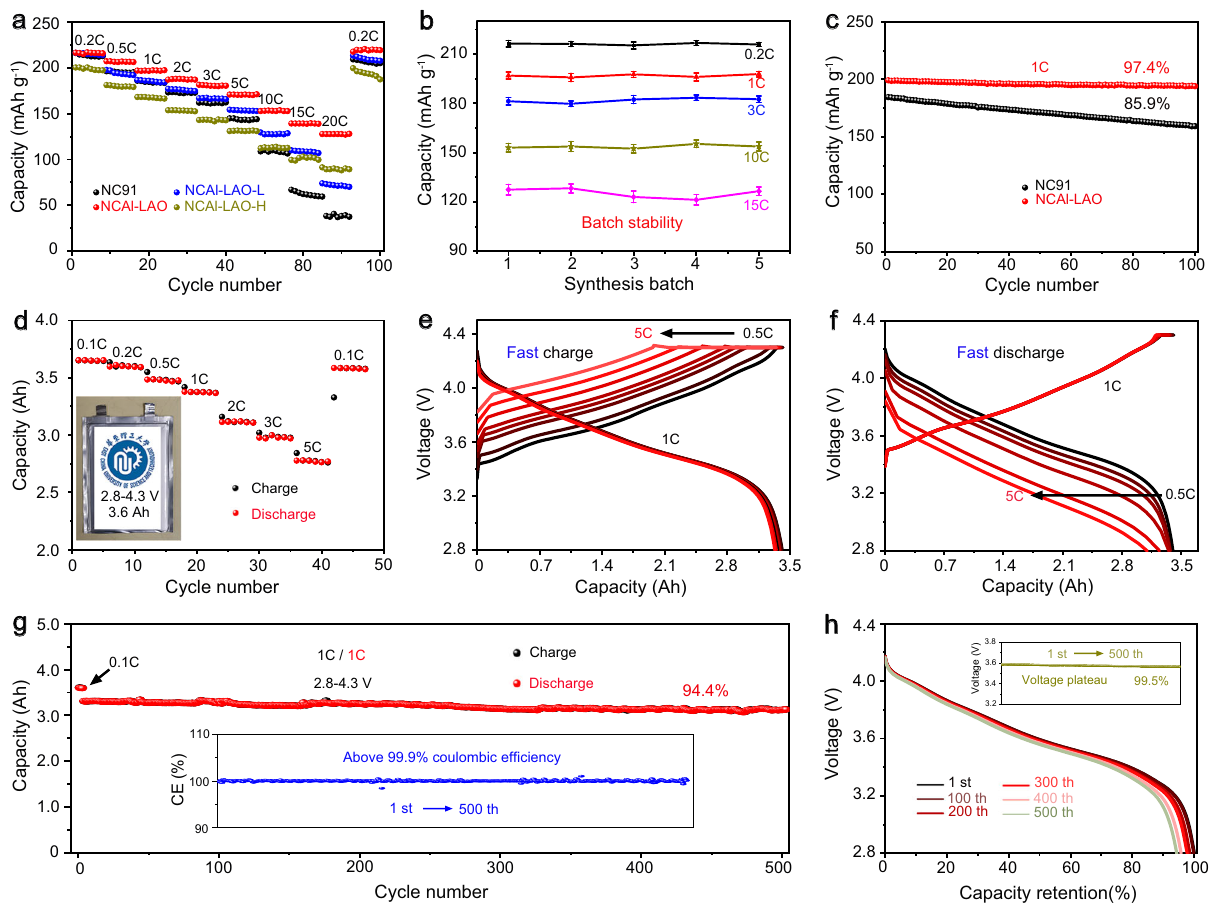
Fig. 3 Electrochemical performances of the cathodes in half-/full cells. a Speci fi c capacities at 0.2 – 20 C of NC91 and various Al-modi fi ed NCAl-LAO for 2.7 – 4.3 V. b Performance stability data of optimised NCAl-LAO from fi ve batches. The error bars represent the standard deviation from fi ve independent tests. c Cycle performance at 1 C of NCAl-LAO and NC91. d Rate capability, e , f rapid charge and discharge performance, g , h cycle stability and corresponding discharge curves of NCAl-LAO/graphite full cells for 2.8 – 4.3 V. Inset in d , pouch cell with capacity of 3.6